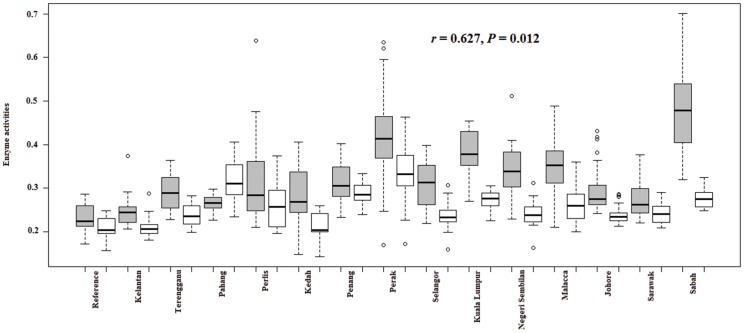
Spearman rank-order correlation between the activity of α-esterases (grey) and β-esterases (white) in Malaysian Culex quinquefasciatus.